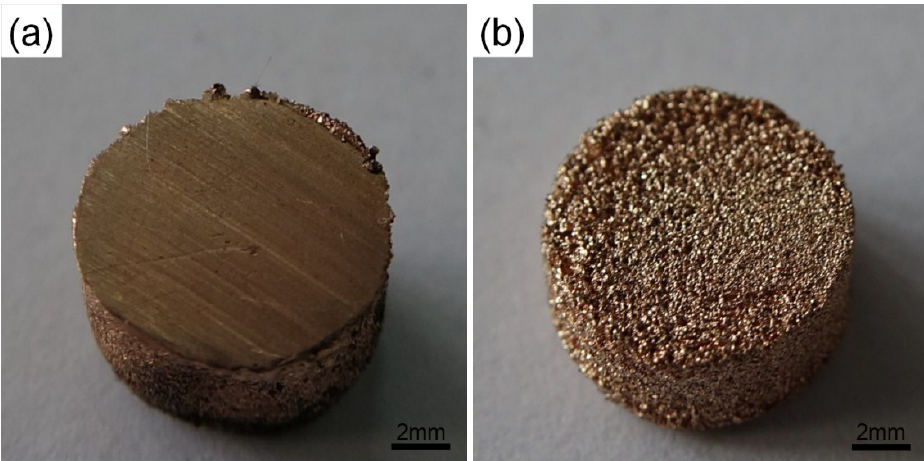
Figure 6. The surfaces of porous Cu in different machining conditions: ( a ) machined in the sintered state; ( b ) machined in the green body